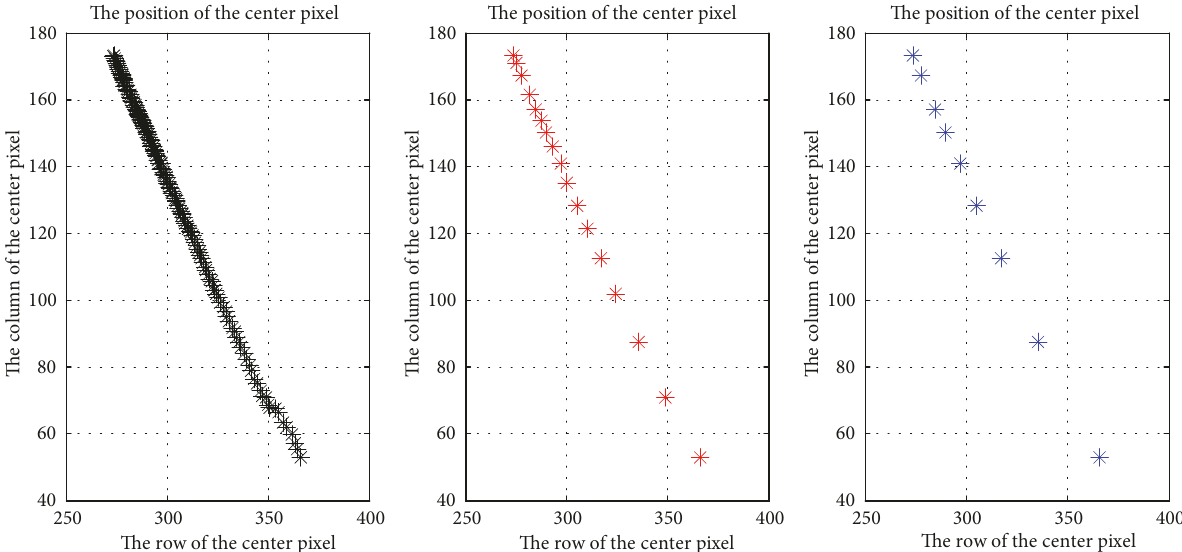
Figure 15: Target trajectory of the center pixel corresponding to sequence S5. From left to right, 𝜐 = 1 , 𝜐 = 10 , and 𝜐 = 20 .